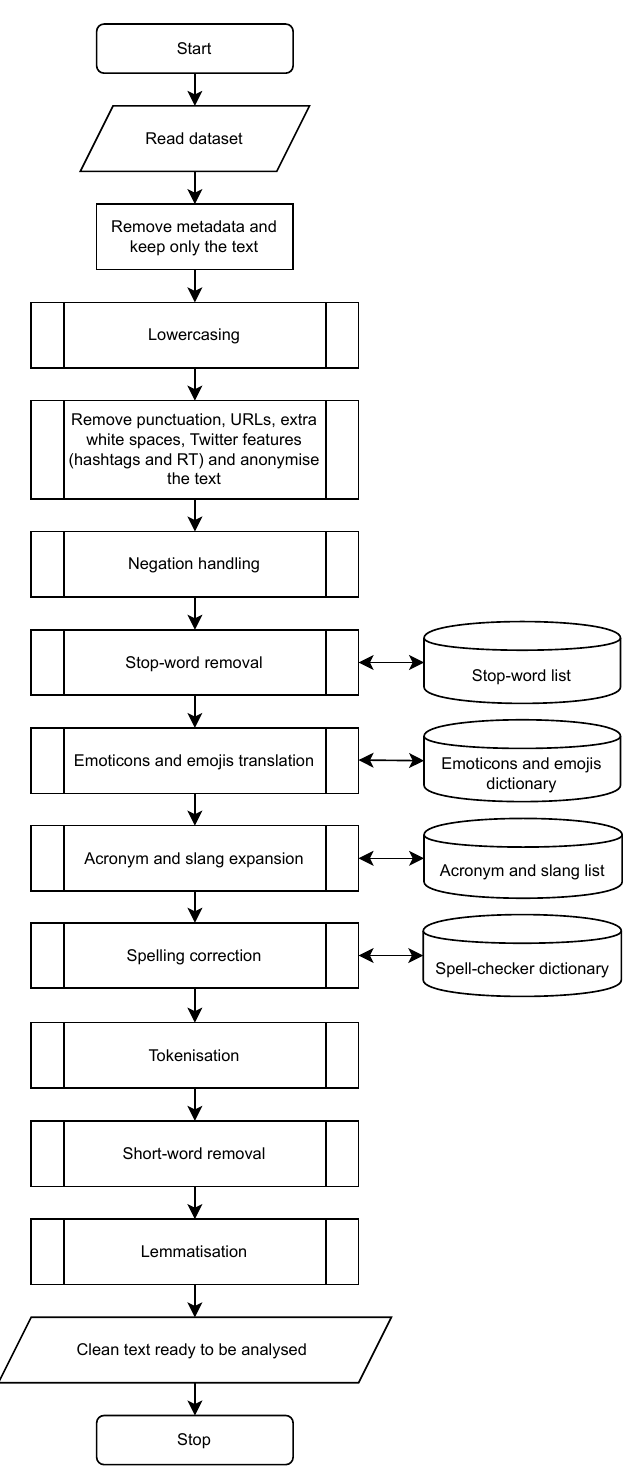
Figure 4. Flow 1: Reference